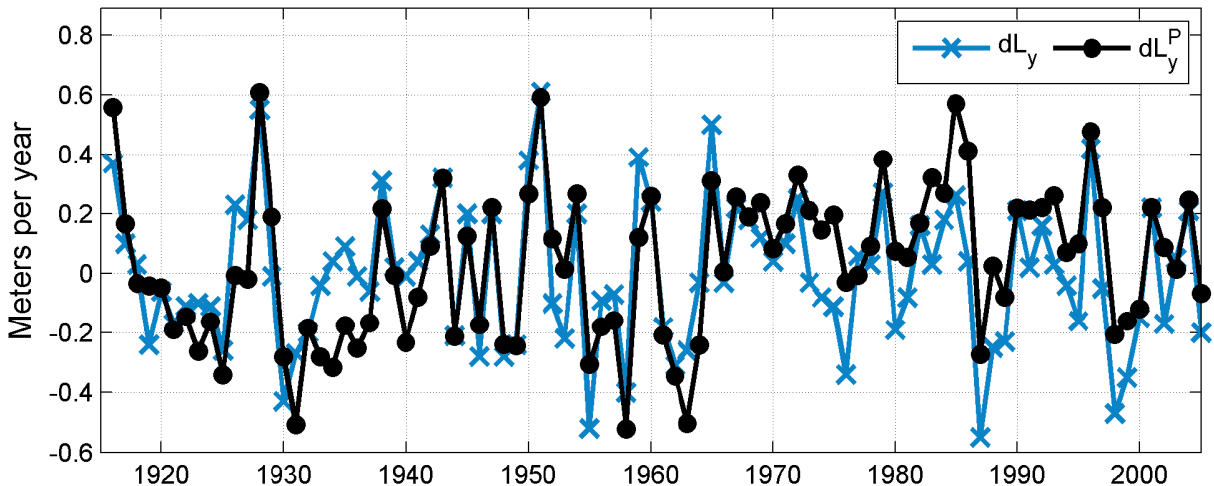
Figure 1. Annual lake-level changes estimated from observed levels ( (cid:1856)(cid:1838) (cid:3052)(cid:3022) ; blue x’s) and as computed by Equation (1) ( (cid:1856)(cid:1838) (cid:3052)(cid:3043) ; black